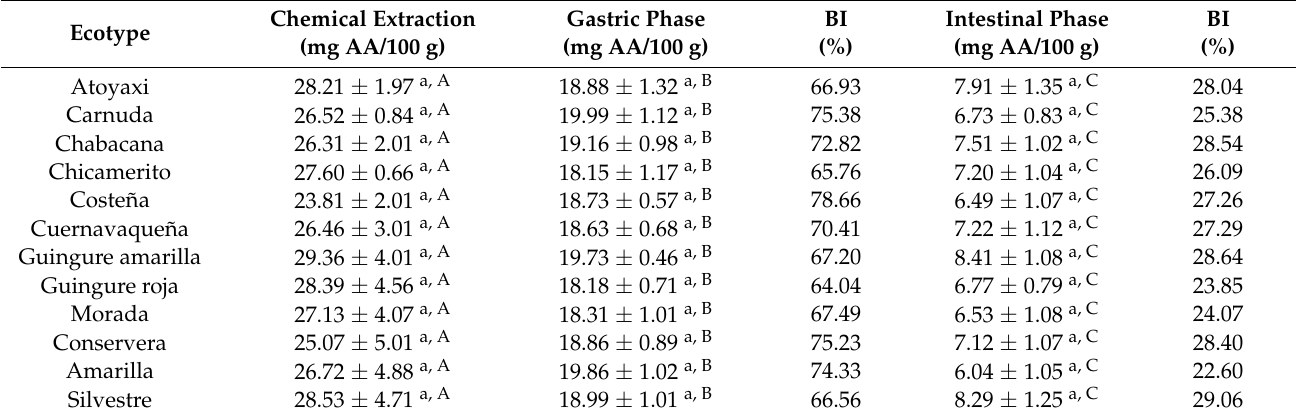
Table 3. Total ascorbic acid content and bioaccessibility index of 12 ecotypes of S. purpurea L. before and after in vitro